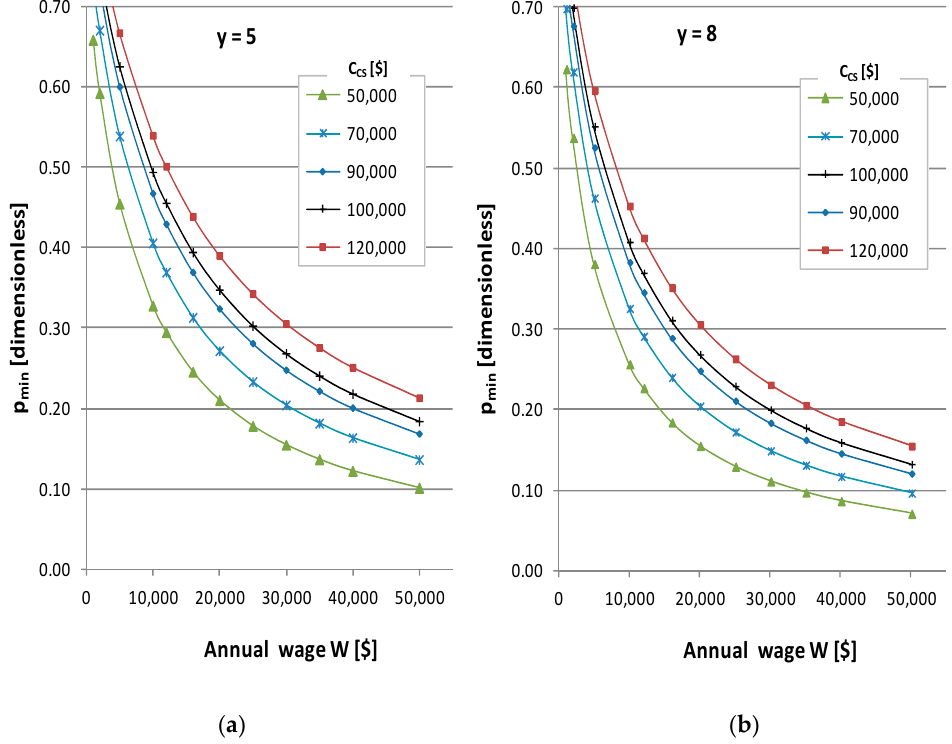
Figure 1. Minimum productivity pmin that supports cobot cost implementation: ( a ) y = 5; ( b ) y = 8.